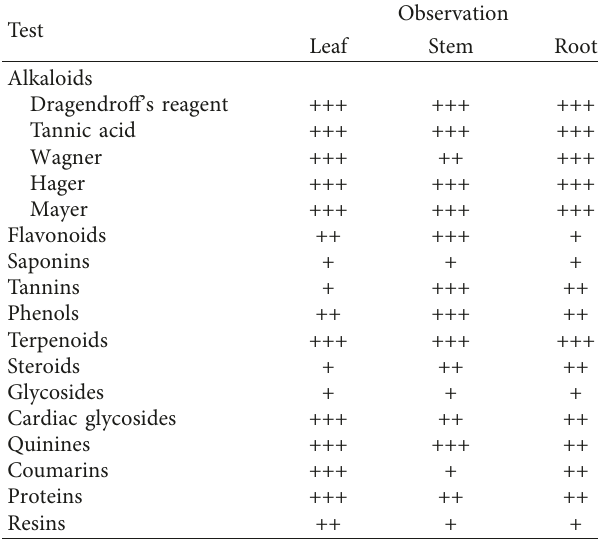
Table 1: Qualitative phytochemical analysis of C. lanatum .